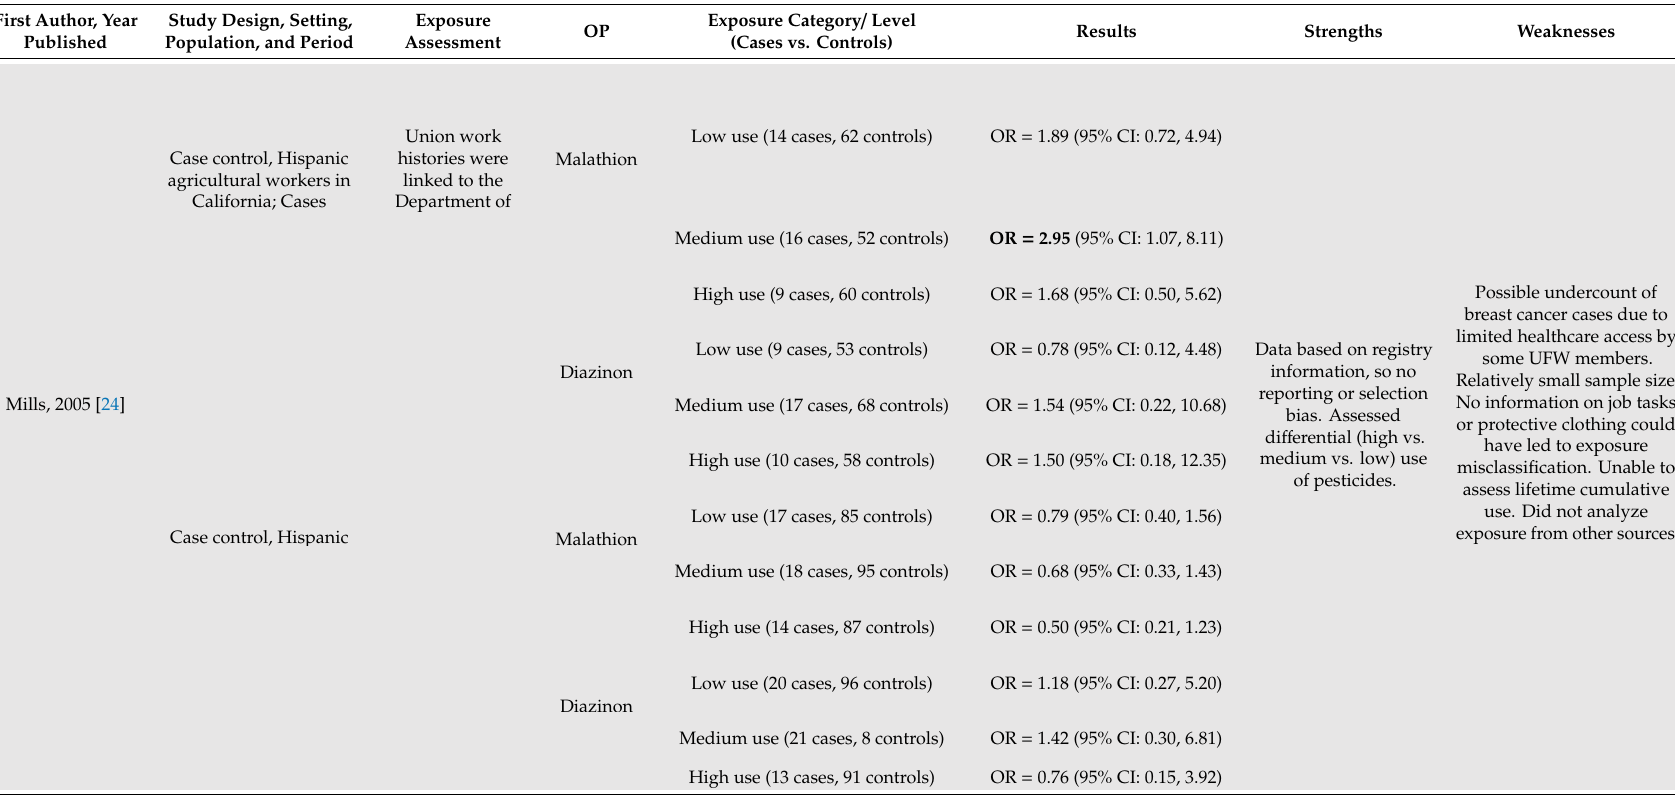
Table 1. Summary of results, strengths, and weaknesses for human studies on organophosphate pesticides and breast cancer